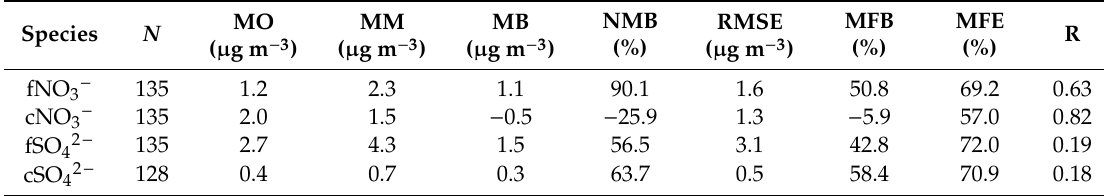
Figure 7. Time series of observed (black dots) and simulated (color-shaded) NO 3− ( a , b ) and SO 42− ( c , d ) in fine ( a , c ) and coarse ( b , d ) mode at Fukuoka. The dark yellow, blue, and magenta shades represent the simulated D-, S-, and A-NO 3− and SO 42− , respectively. The pie charts show the fraction from each chemical pathway of NO 3− formation. Table 2. Statistics for the observed versus modeled fine and coarse nitrate and sulfate in Fukuoka.